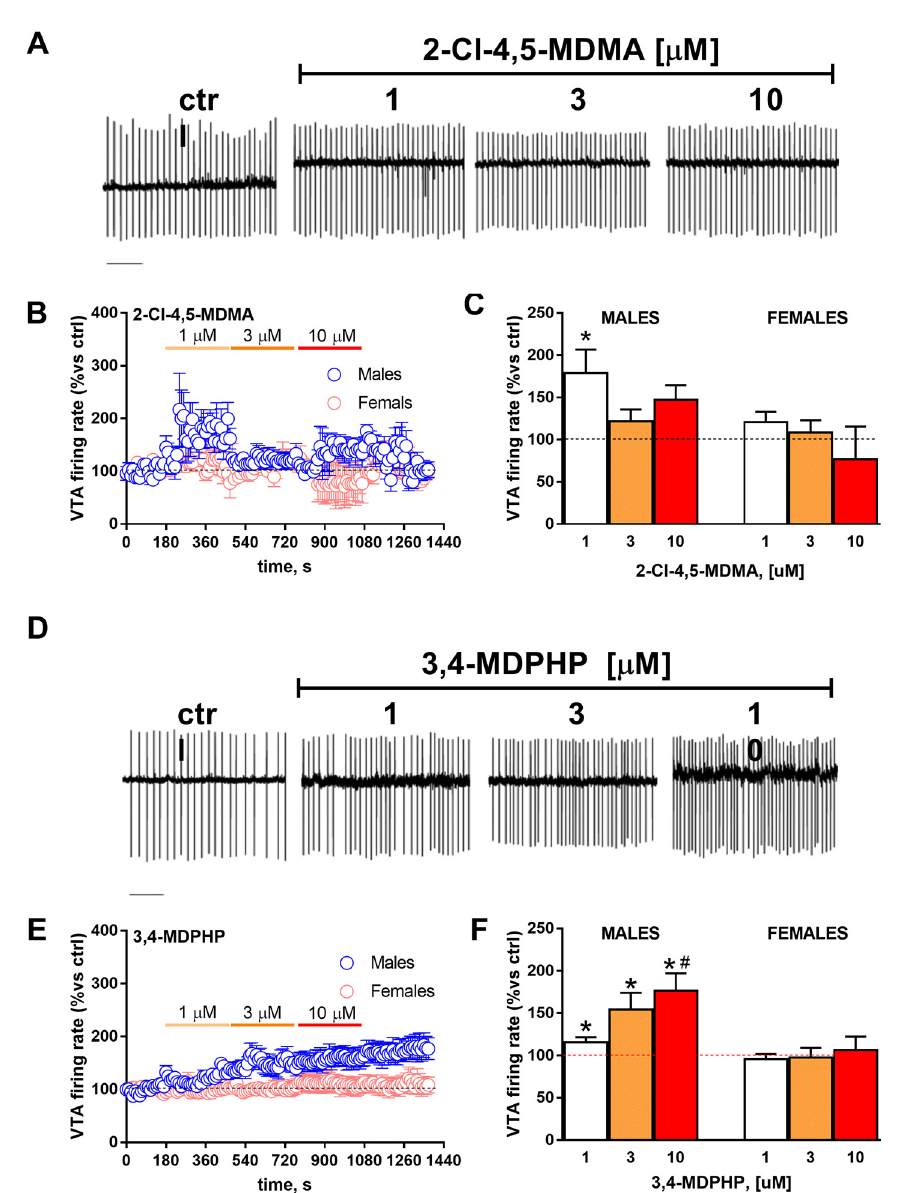
Figure 4. Effect of slice perfusion with 2-Cl-4,5-MDMA or 3,4-MDPHP on firing rate of rVTA dopaminergic neurons . ( A ) Representative traces recorded in cell-attached mode from a single dopaminergic neuron from rVTA obtained in a male rat before and after the application of different concentrations of 2-Cl-4,5-MDMA. Scale-bar, 1 s. ( B ) Scatter plot indicating the effect of bath perfusion of increasing concentrations of 2-Cl-4,5-MDMA (1–10 µ M) in the firing rate of rVTA dopaminergic neurons obtained in both male and female rats (5/5). ( C ) Bar graph representing the averaged effects reported in panel B for any single concentration of 2-Cl-4,5-MDMA perfused in the slice (5/5). * p < 0.05 vs control values. ( D ) Representative traces recorded in cell-attached mode from a single dopaminergic neuron from rVTA obtained in a male rat before and after the application of different concentrations of 3,4-MDPHP. Scale-bar, 1 s. ( E ) Scatter plot indicating the effect of bath perfusion of increasing concentrations of 3,4-MDPHP (1–10 µ M) in the firing rate of rVTA dopaminergic neurons obtained in both male and female rats (5/5). ( F ) Bar graph representing the averaged effects reported in panel E for any single concentration of 3,4-MDPHP perfused in the slice (5/5). * p < 0.05 vs control values, # p < 0.05 vs 1 µ